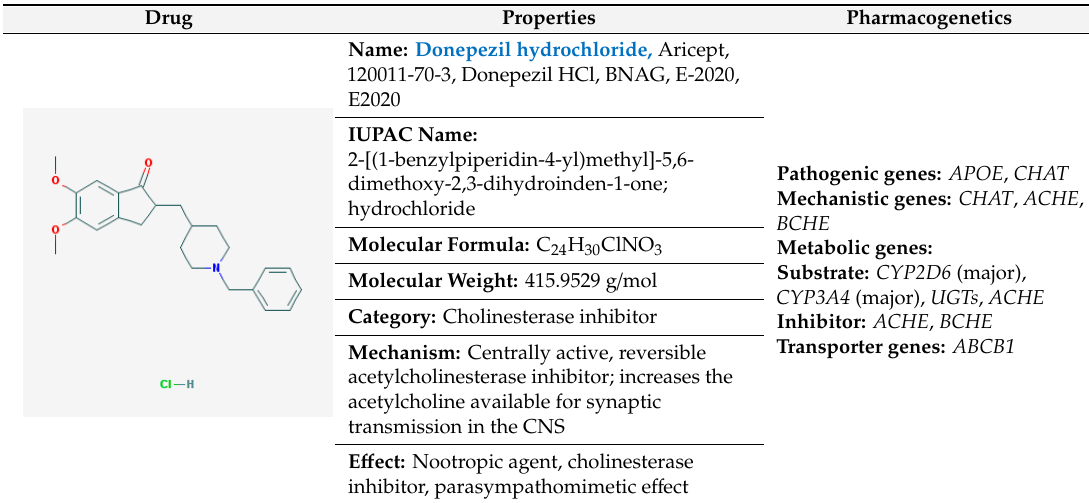
Table 2. Pharmacogenetics of conventional anti-dementia